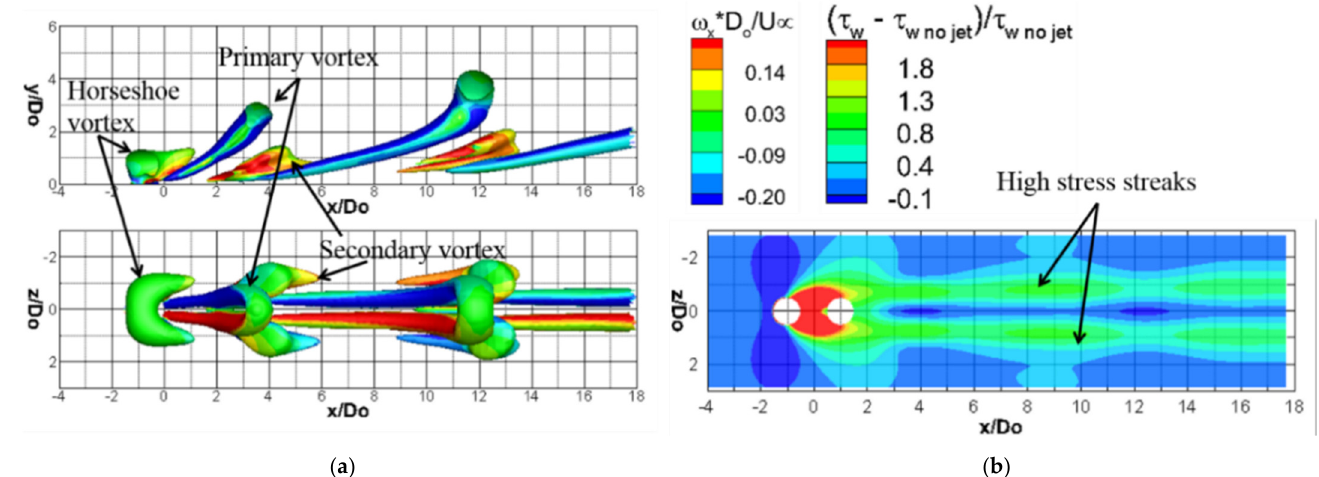
Figure 11. Vortex structures in the single-SJ case, captured using Q = 1 iso-surfaces ( a ) and excess wall shear stress ( b ) at t / T = 0.